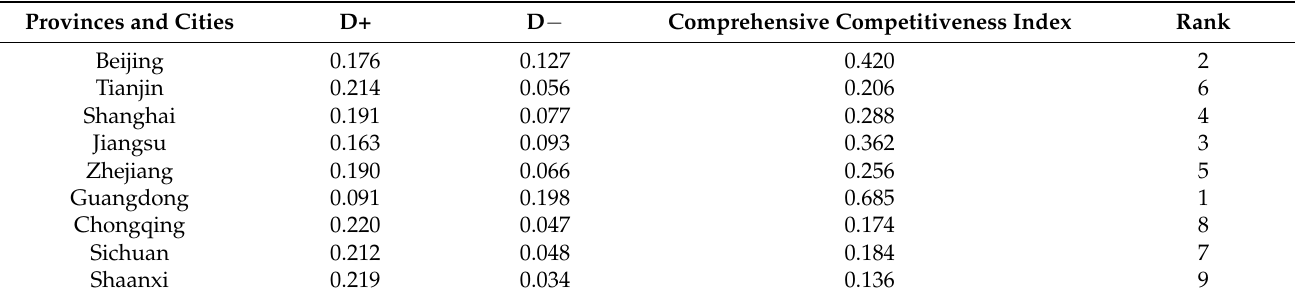
Table 5. Comprehensive evaluation results of talent competitiveness in the intelligent industry in nine provinces and cities in 2018.